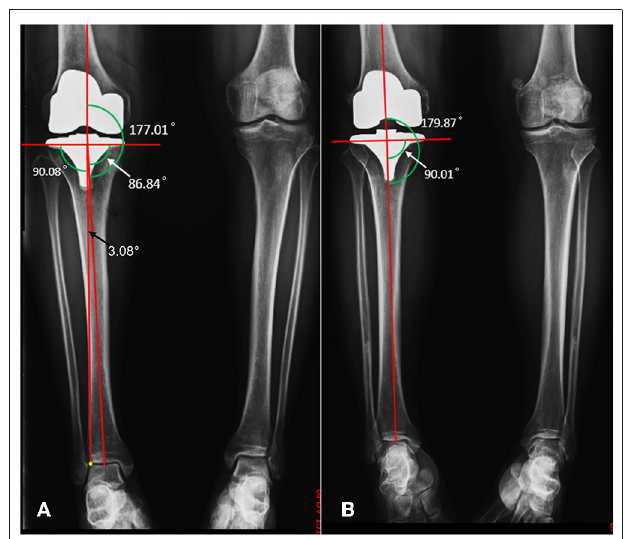
FIGURE 5 | Postoperative radiological images of AA (A) and MA (B) . MPTA, white arrow; TAMA, black arrow; LADT, yellow point.